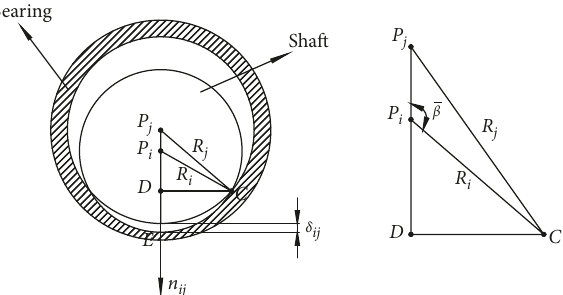
Figure 3: Contact form and geometric relationship of revolute joint considering